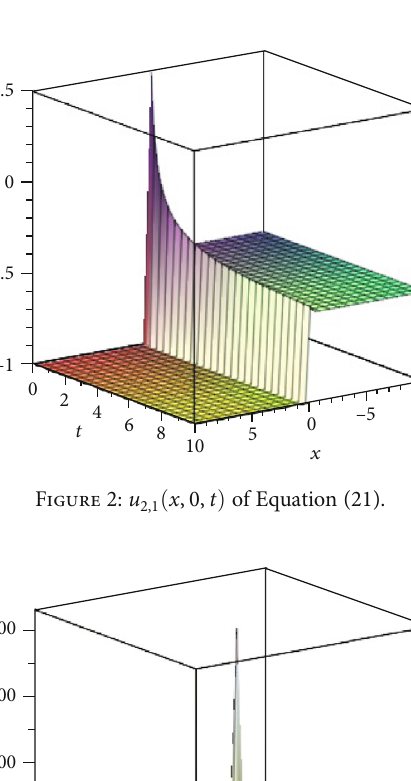
ð x , 0, t Þ of Equation (21). Figure 1: u 1,1